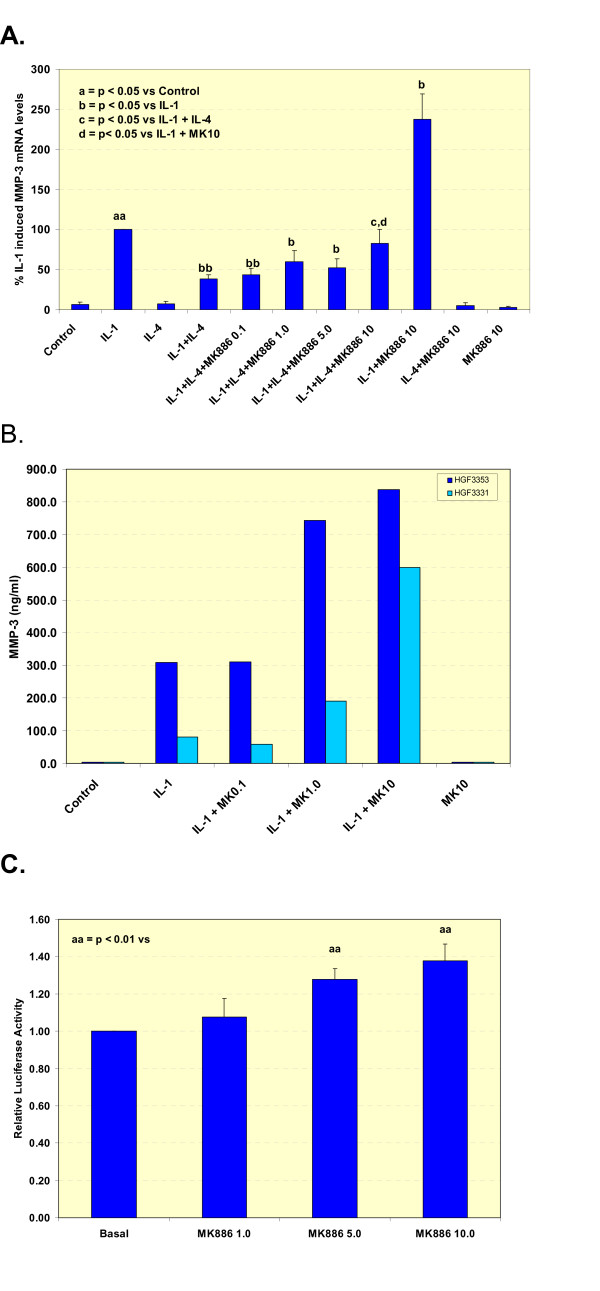
A specific inhibitor of 5-lipoxygenase, MK886, super-induces MMP-3 mRNA and protein. HGF cultures were pre-treated with NDGA at the indicated doses for 1 hour prior to addition of IL-1 (10 ng/ml) and/or IL-4 (10 ng/ml). A) Total RNA was harvested 12 hours after cytokine treatment, quantitated by real-time PCR and normalized to levels of GAPDH mRNA. The graph represents five independent experiments performed in triplicate, expressed as mean +/- SEM. B) Conditioned medium was collected from cultures after 24 hours incubation with cytokines +/- MK886 at the indicated doses. MMP-3 protein levels were determined by ELISA. The graph shows data from two different HGF cultures derived from two different donors. C) COS-1 cells were transiently transfected with a luciferase reporter construct containing 2300 bp of the human MMP-3 5' flanking sequence, along with an SV-β-gal reporter as a control for transfection efficiency. MK886 was added 16 hours after transfection, and cells were harvested 24 hours later. Shown are data from three independent experiments performed in triplicate, normalized to levels of β-galactosidase, and expressed relative to control, mean +/- SEM. Statistical significance was determined using Student's t-test.